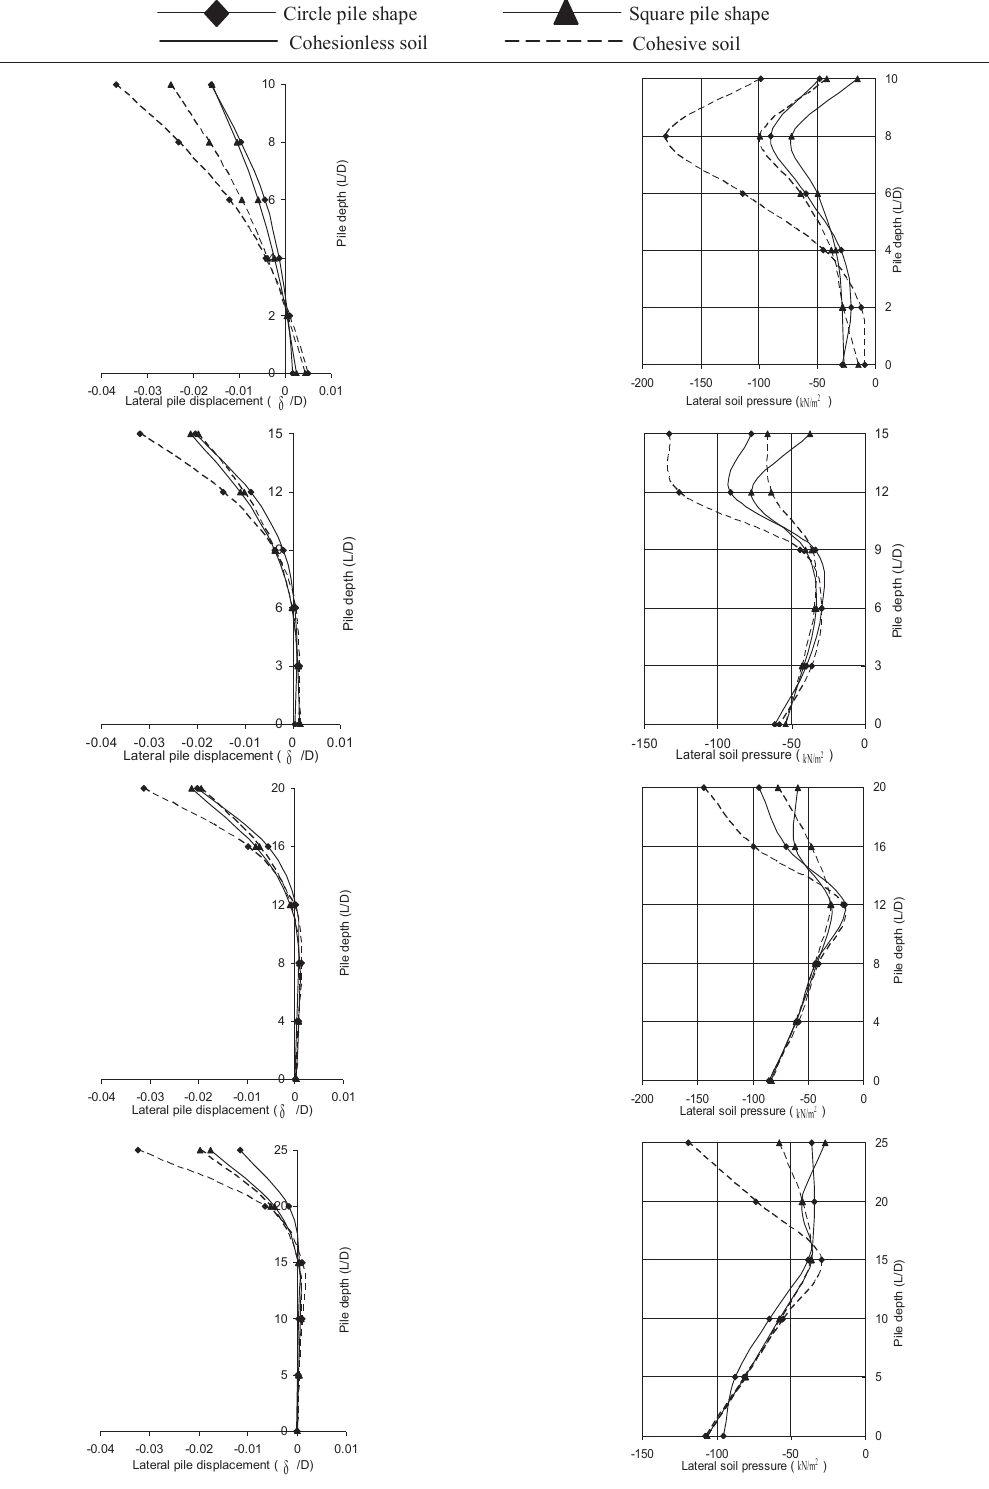
Figure 7 Influence of pile shape on the lateral soil pressure distribution of pile embedded on both cohesionless and cohesive soils: (a) L = 10 m, (b) L = 15 m, (c) L = 20 m and (d) L =25 m Figure 7: Influence of pile shape on the lateral soil pressure distribution of pile embedded on both cohesionless and cohesive soils: (a) L = 10 m, (b) L = 15 m, (c) L = 20 m and (d) L =25